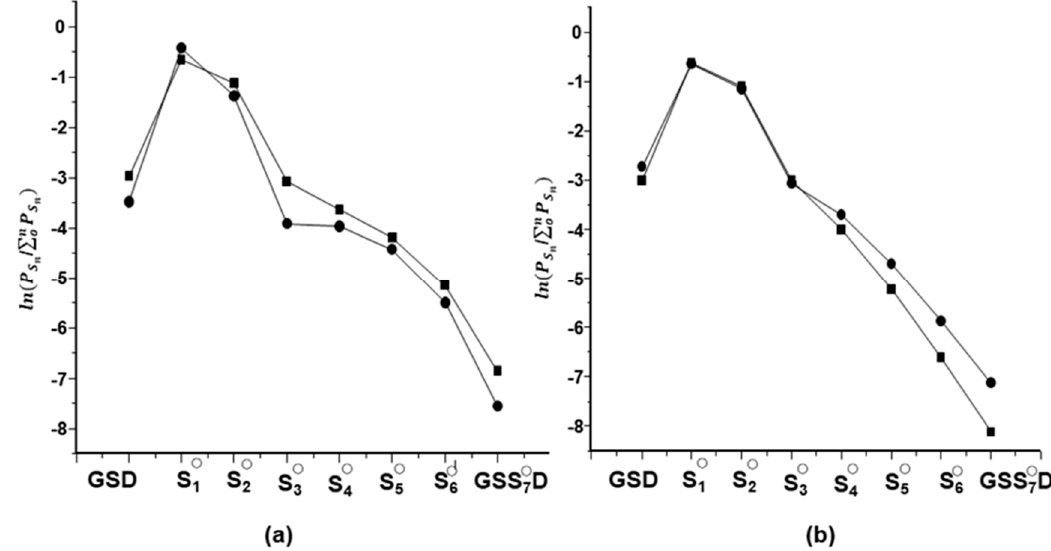
Figure 5. Relative yields of GSS n D adducts in ( a ) aerobic and ( b ) anaerobic reactions between GSNO and Na 2 S (1:5 mM) with DH present in situ (squares in a & b ) or added after 1 h initiation (circles in a & b ) as calculated from the peak area of the SICs.